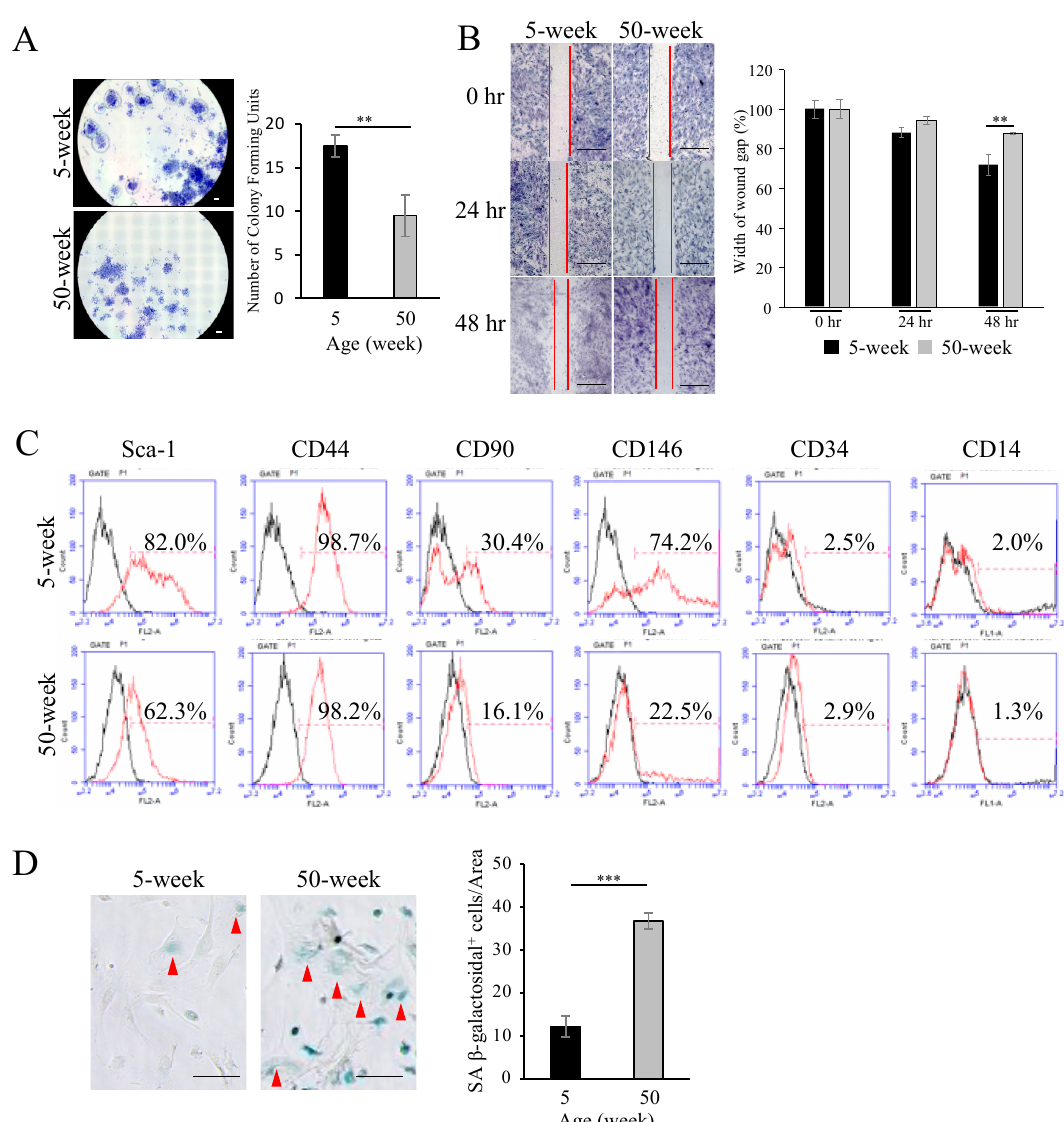
Figure 5. Functional impairment of MSCs from aged mice. ( A ) Photograph and graph showing the quantitative analysis of the number of colonies (CFU-f) formed from flushed bone marrows from young and aged mice. Bar: 500 µ m. Note that the CFU-f number is significantly lower in specimens from aged mice. The bar graph represents the mean ± standard deviation of at least 3 independent samples. ** p < 0.01, unpaired Student’s t -test, n = 3. ( B ) Representative images of an in vitro wound healing (scratch) assay using MSCs isolated from young and aged mice. Bar: 500 µ m. Note that aged MSCs show slower migration ability compared to MSCs from young mice. The bar graph represents the mean ± standard deviation of at least 3 independent samples. ** p < 0.01, two-way ANOVA, Tukey test, n = 3. ( C ) Expression of major surface antigen markers for MSCs (Sca-1, CD44, CD90, CD146) in young and aged MSCs determined by flow cytometry. Note that the MSCs show almost no expression of the hematopoietic stem cell markers, CD14 and CD34. Note also that all markers, except for CD44, were significantly decreased in aged MSCs. ( D ) Staining and quantitative analysis of senescence-associated (SA) β -Gal + cells (Red arrow) showing a significantly higher number of senescent cells in aged compared to young MSCs. Bar: 100 µ m. The bar graph represents the mean ± standard deviation of at least 3 independent samples. *** p < 0.001, unpaired Students’ t -test, n = 3.